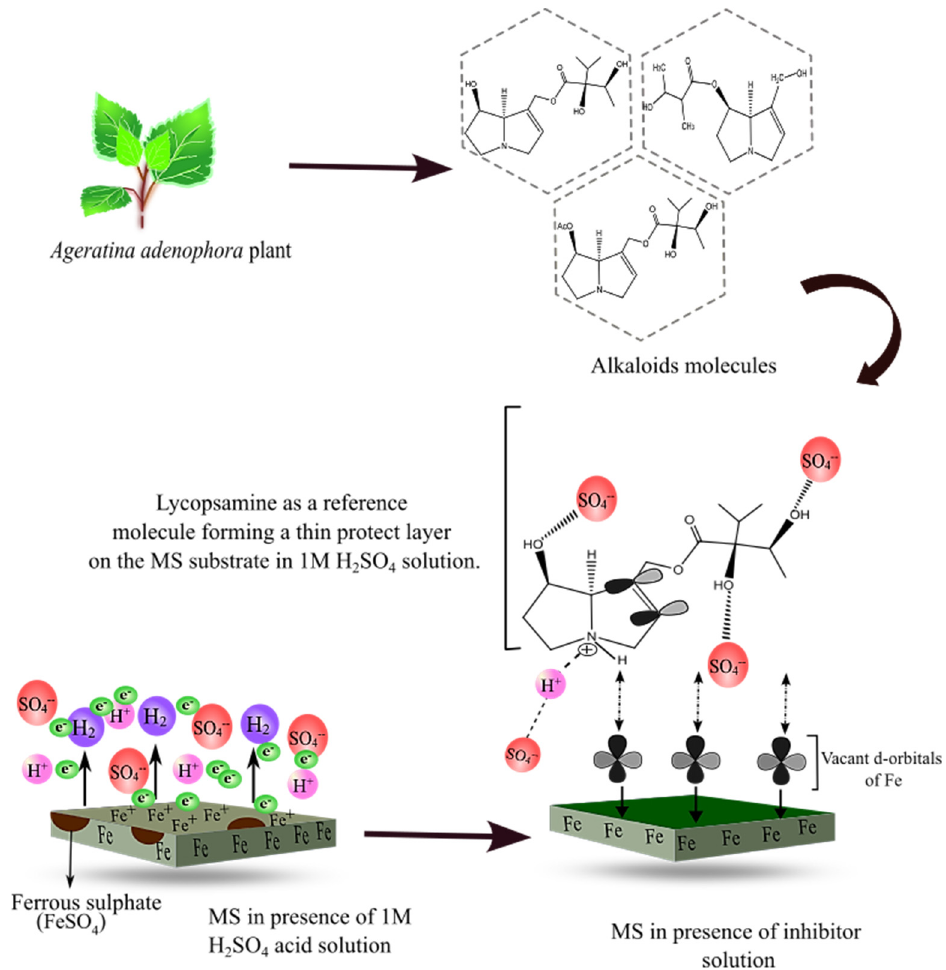
Figure 14. Schematic diagram showing the mechanism of corrosion inhibition by alkaloid molecules in reference to lycopsamine molecule.